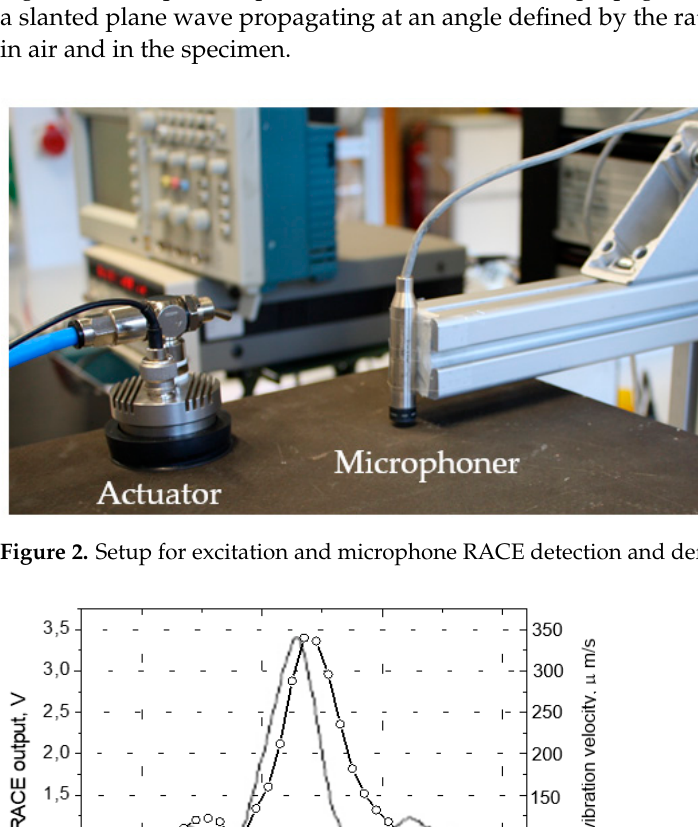
Figure 2. Setup for excitation and microphone RACE detection and defect imaging.